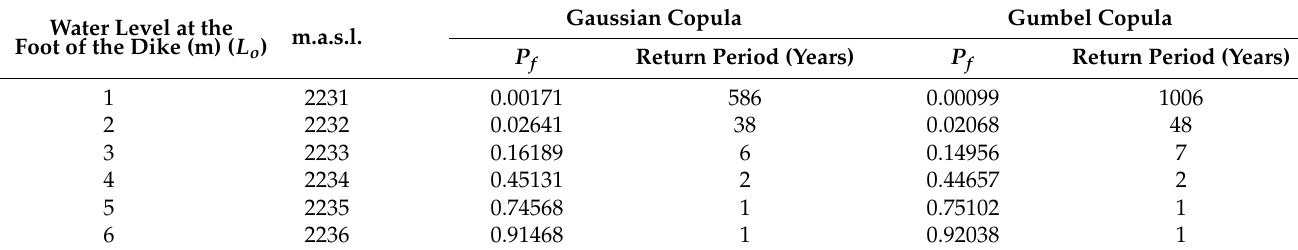
Table 5. Probability of failure for different initial water levels ( L o ) as calculated with the Gaussian and Gumbel time series. Water Level at the Foot of the Dike (m) ( L o )